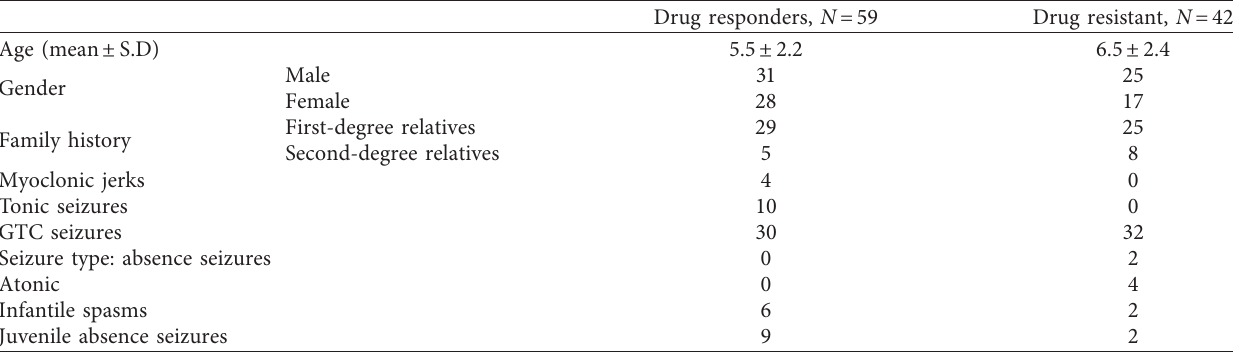
GTC:generalized tonic clonic. Table 3: Distribution of genotypic and allelic frequencies among cases and controls. Genotypes/alleles